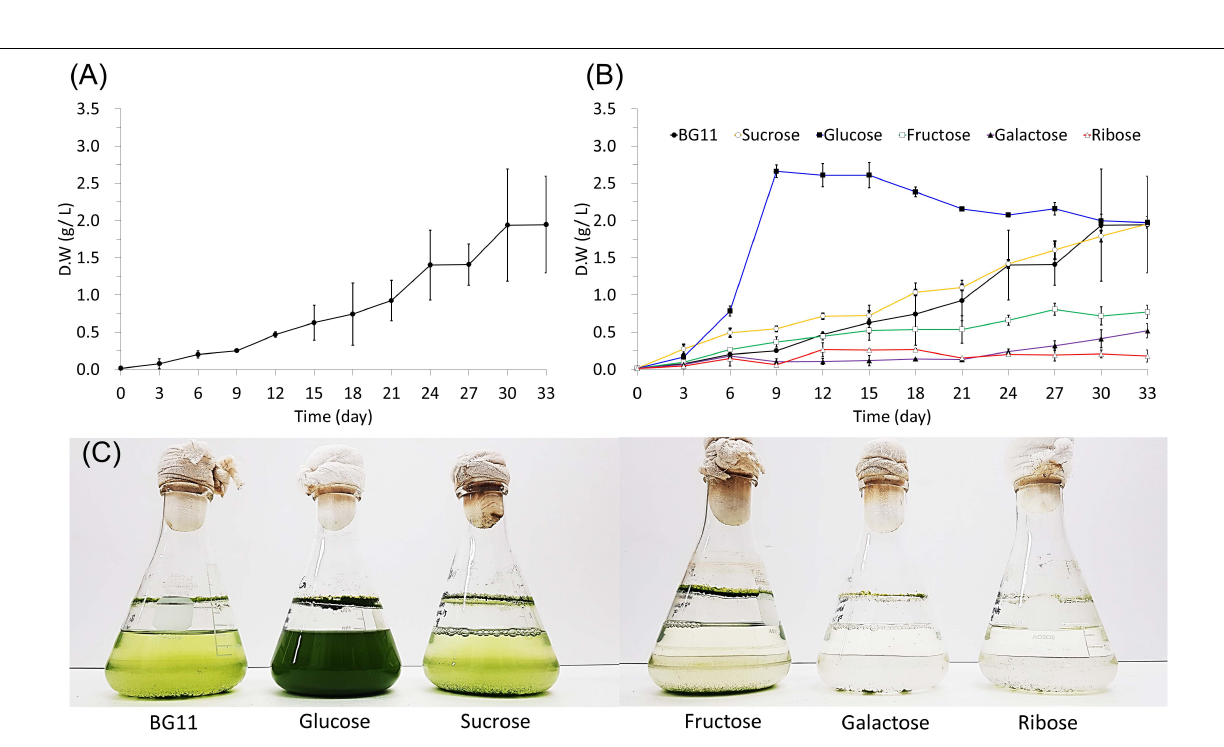
Frontiers in Genetics |